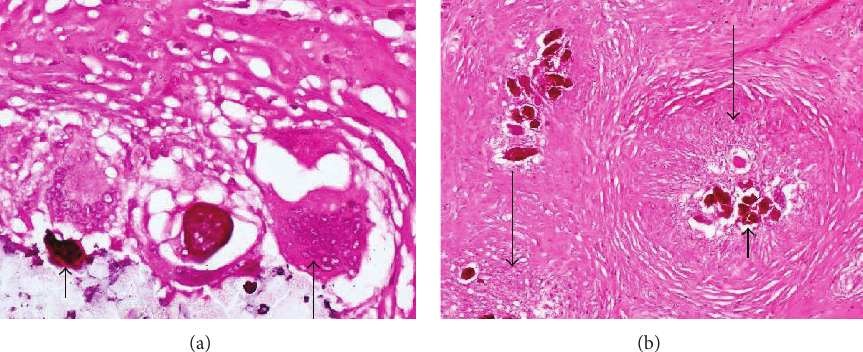
Figure 4: Photomicrographs showing calcified schistosome ova (short arrows), inflammatory giant cell (medium arrow), and granuloma surrounding the ova (long arrows), in the right tube.